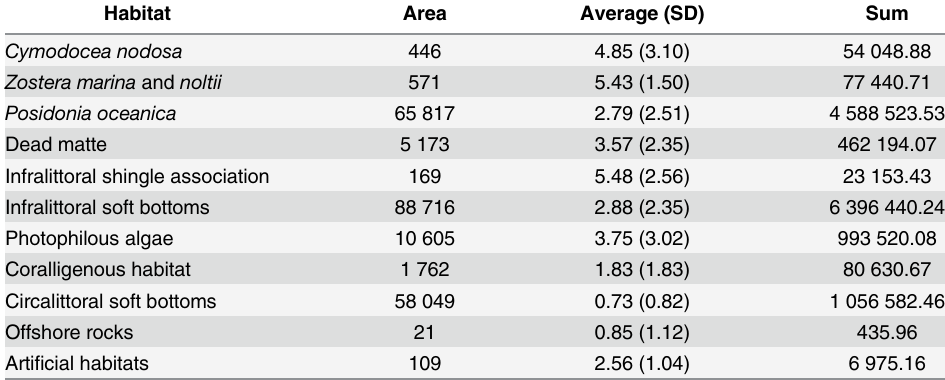
Table 1. Analysis of the cumulative impact scores per marine habitat. Average, standard deviation (SD) and sum of the cumulative impact scores ( I C ) obtained by each 20 x 20 m cell composing each marine habitat ( j ). Areas of the habitats are indicated in